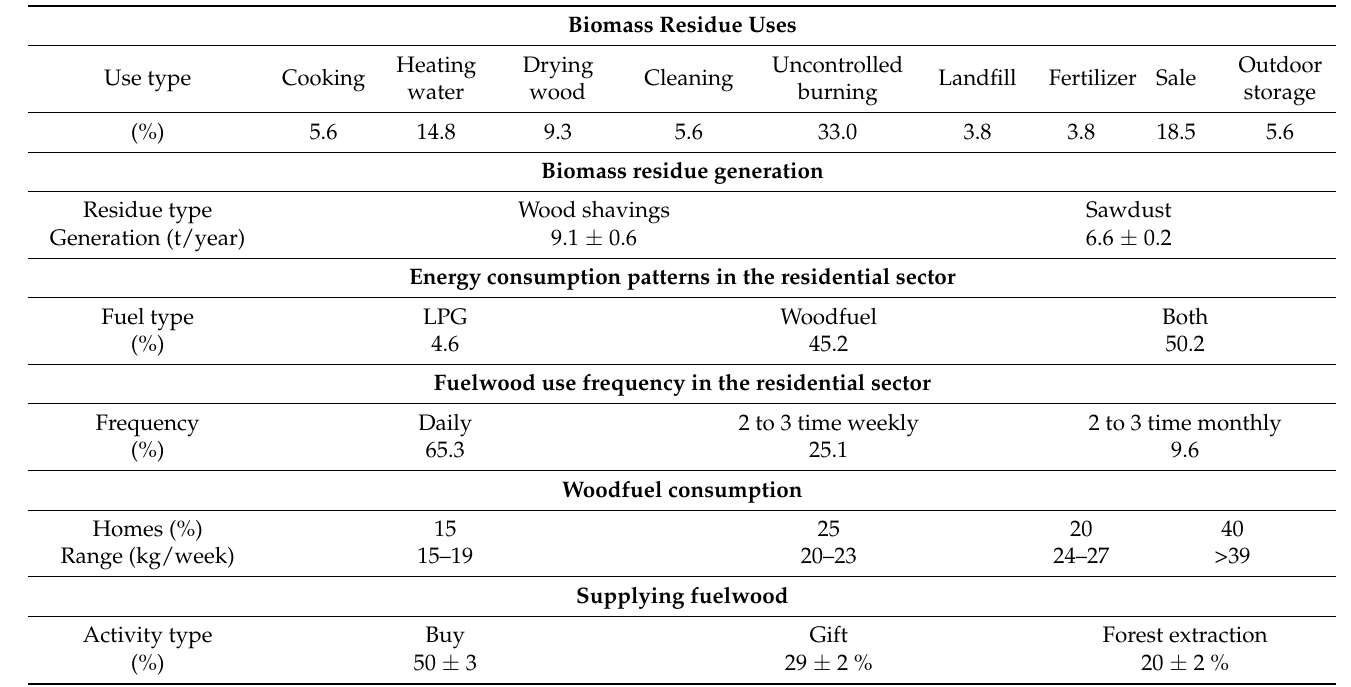
Table 1. Biomass residue and consumption patterns in the residential sector of San Francisco Pich á